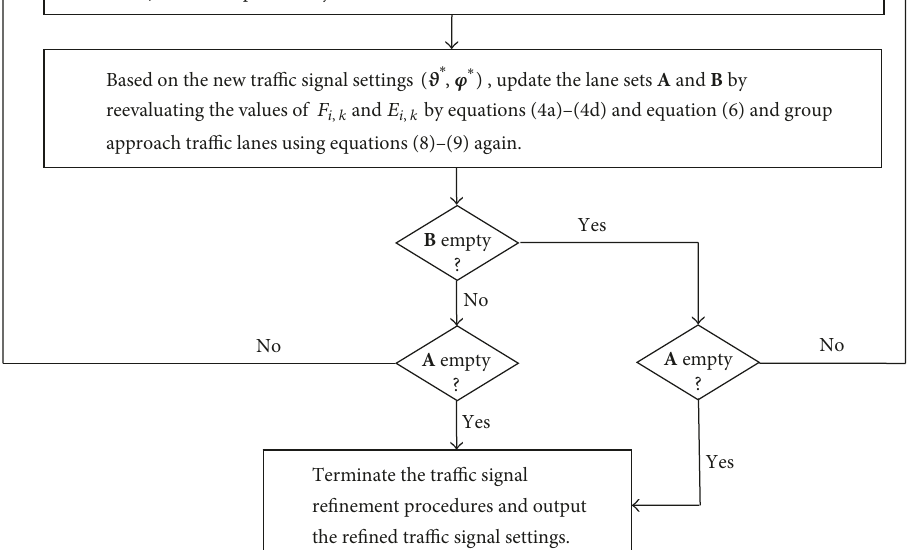
Figure 7: Proposed search heuristics for refining the traffic signal